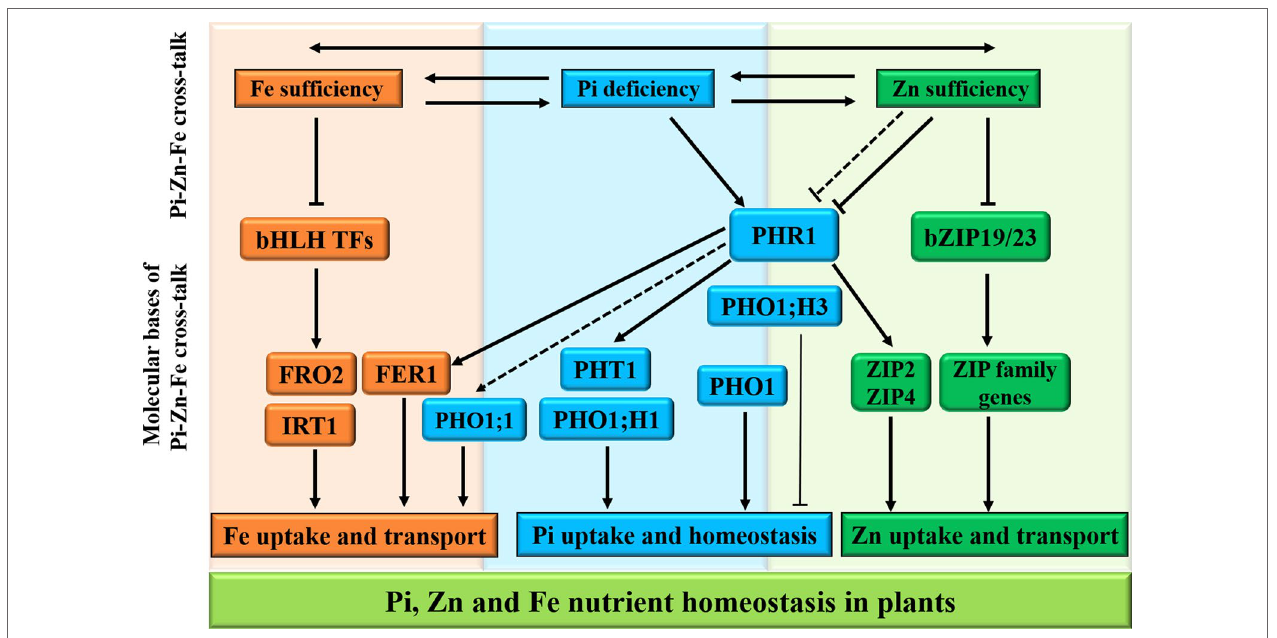
FIGURE 3 | Schematic representation of Pi, Zn, and Fe homeostasis interactions in plants. The cross-talks between phosphate (Pi), zinc (Zn), and iron (Fe) nutrients are shown at the physiological level by two-way arrows. For the molecular bases of the Pi–Zn–Fe cross-talks, the PHR1 acts as a potential integrator of Pi, Zn, and Fe nutrient signals in plants. Firstly, the PHR1 was defined as a key regulator of the expression of Pi transporters PHT1 and PHO1; H1 through the PHR1–miR399–PHO2 pathway (see Figure 2 ). Secondly, ZIP2 and ZIP4 genes, belonging to plant ZIP gene family, are transcriptionally induced via the activated PHR1 transcription factor binding to the P1BS (GNATATNC) sequences found in the promoter regions of their genes. Under Zn sufficiency, the bZIP19/23 transcription factors are inactivated, and bZIP19/23-mediated Zn regulatory pathways repress the plant ZIP gene family transporters in order to regulate Zn homeostasis. On the other hand, PHO1;H3 , which is transcriptionally down-regulated by high Zn supply, and the PHR1 and PHO1 proteins contribute to the Pi–Zn nutrient homeostasis cross-talk. In addition, the transcriptional activation of some genes involved in maintaining Fe homeostasis is also shown to be PHR1-dependent manner, including the FER1 gene encoding the Fe storage protein ferritin, and the PHO1;1 gene encoding Pi transporter. The arrows and flat-ended lines indicate the positive and negative interactions,